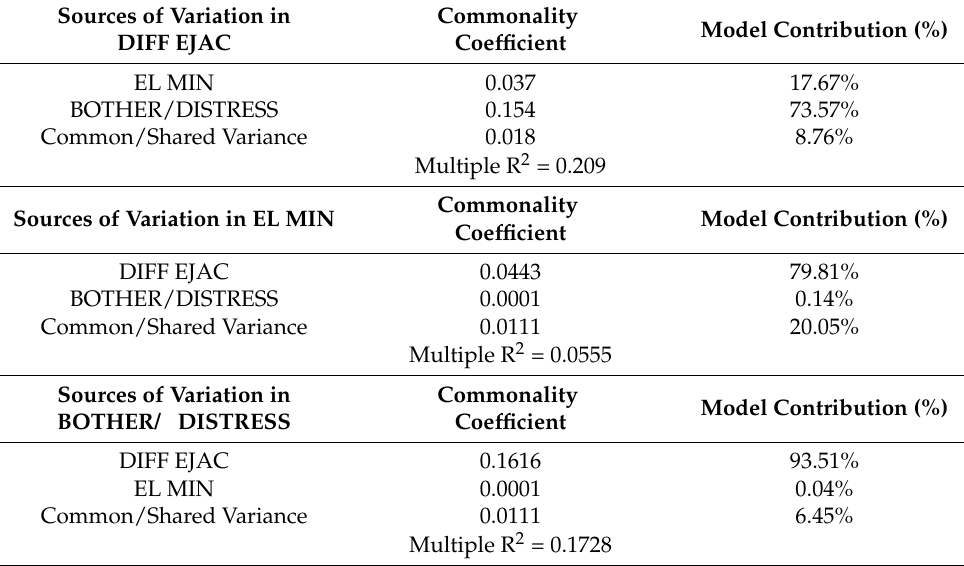
Table 4. Commonality analyses for proposed ejaculation parameters ( n =